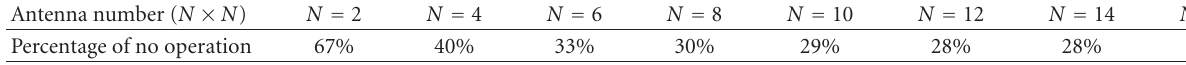
Table 1: The percentage of no operation after index k is decreased.